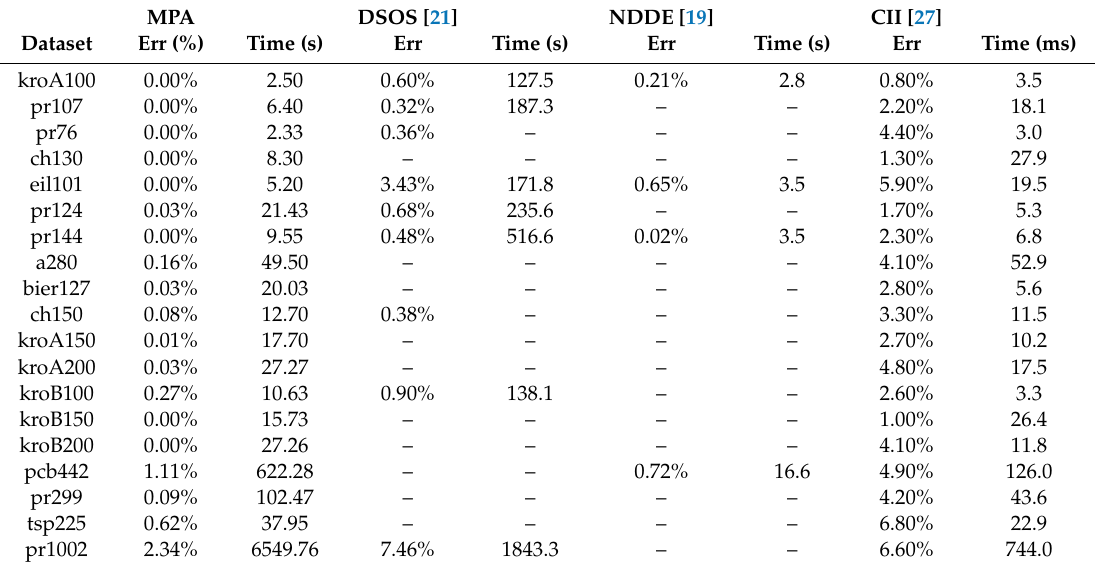
Table 6. Comparison of the performance of the mushroom-picking algorithm (MPA) with other algorithms (TSP